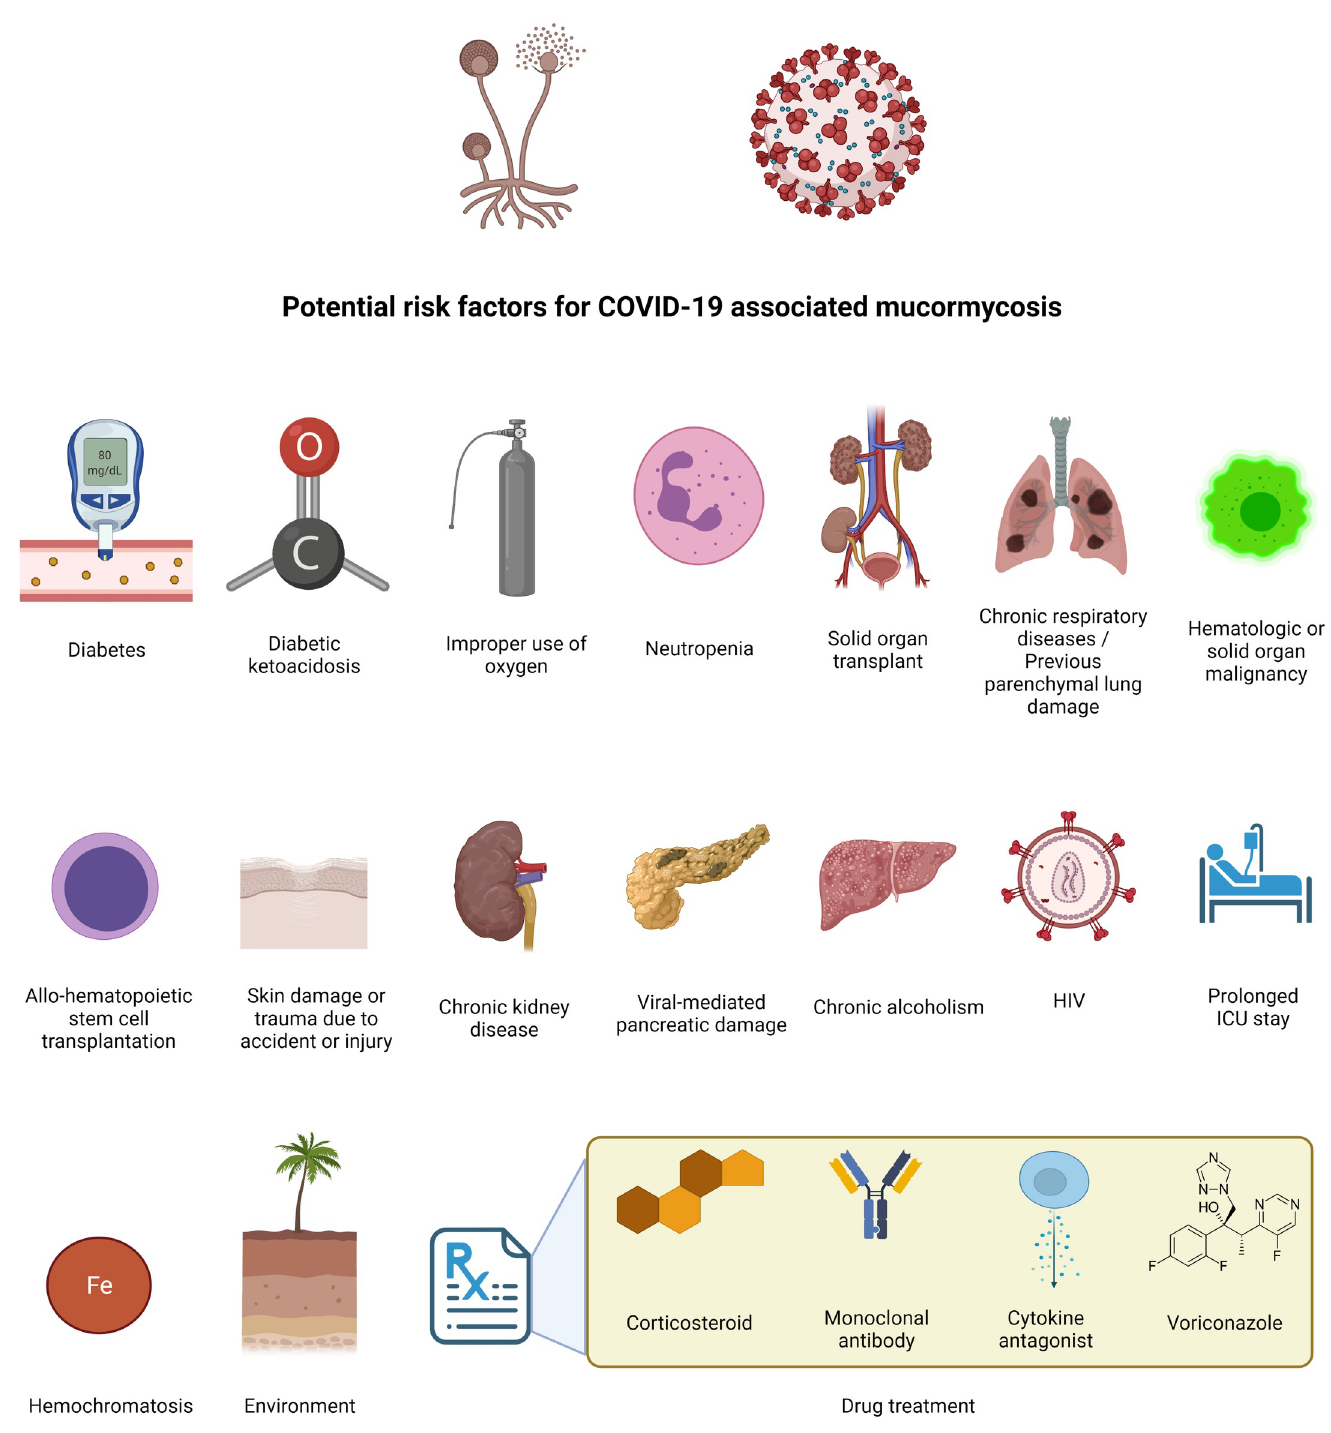
Fig 1. Potential risk factors for COVID-19–associated